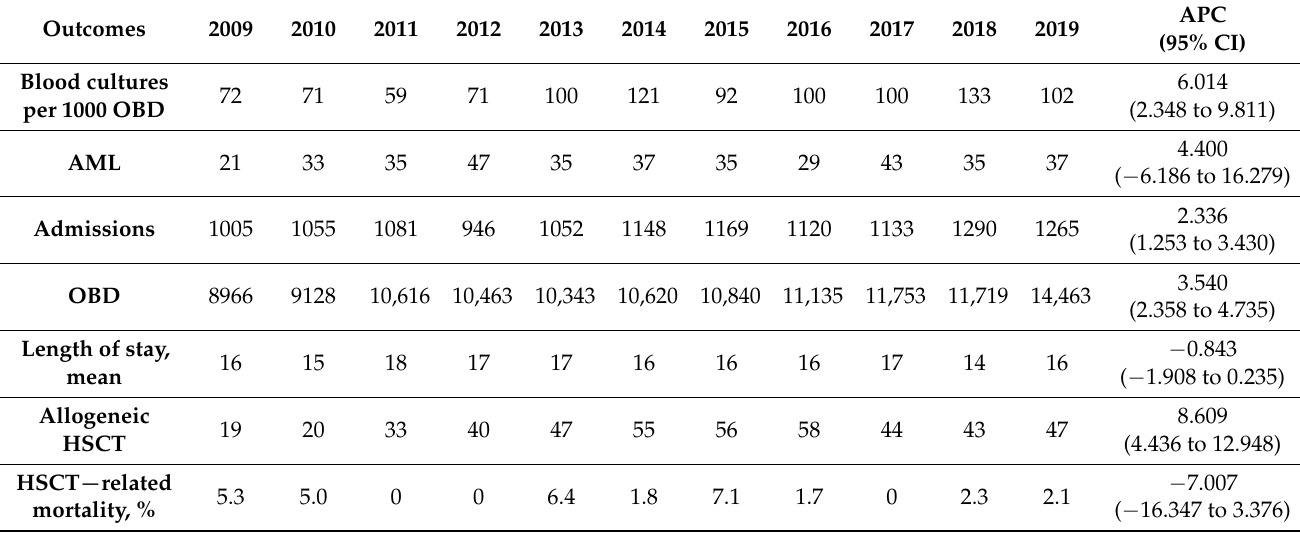
Table 3. Indicators related to the volume and complexity of the activity at the hematology